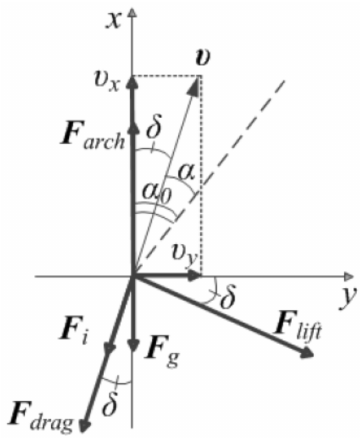
Figure 3. Illustration of the hydrodynamic forces acting on the ball-wing